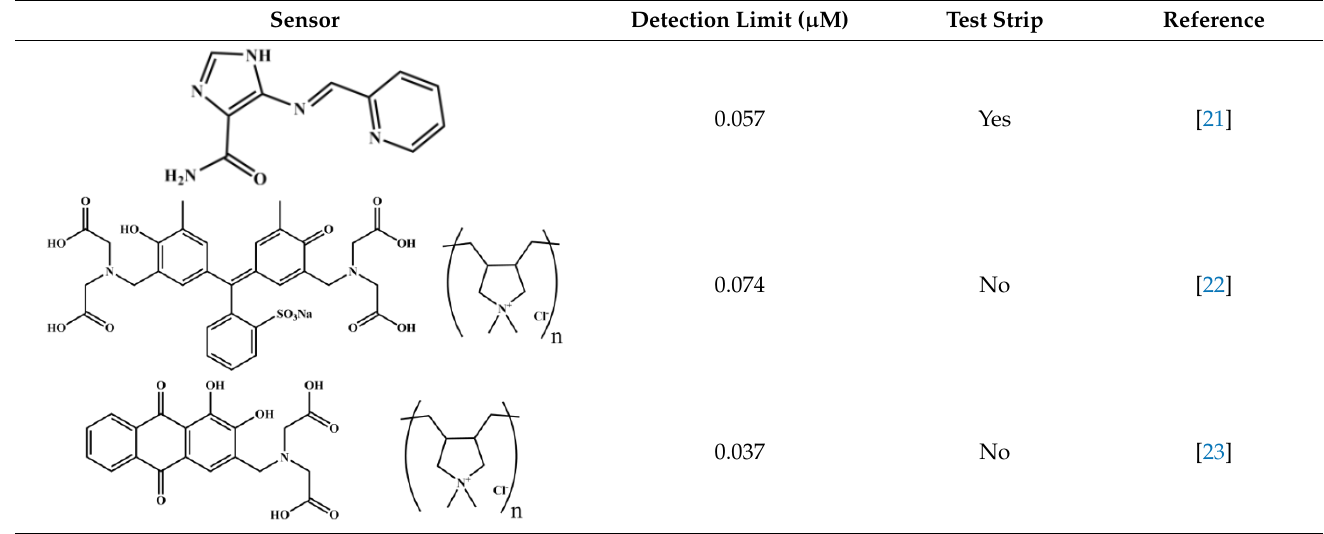
Table 1. Examples of chemosensors for detection of Ni 2+ .